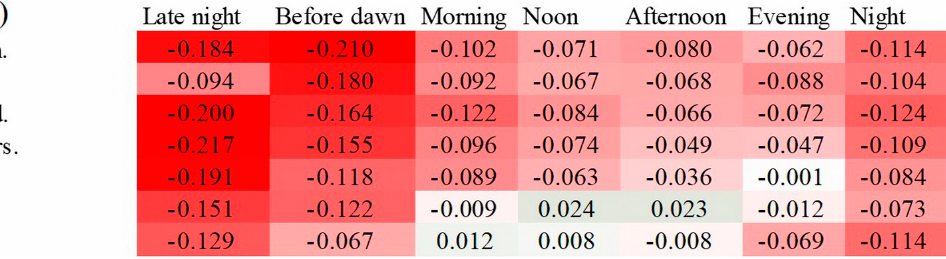
Figure 7. NSR s by ( a ) land uses and times of the day; ( b ) land uses and days of the week; and ( c ) times of the day and days of the week.